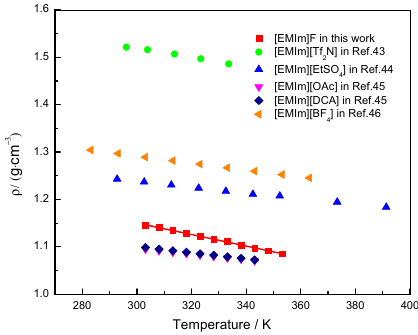
Figure 3. Temperature dependence of the densities of [EMIm]F and similar ILs.